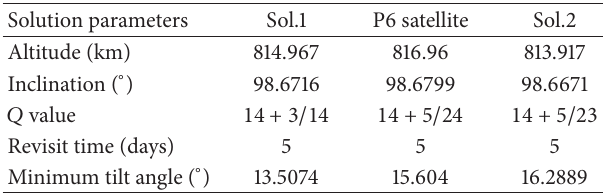
Table 7: Parameters and characteristics of some orbit